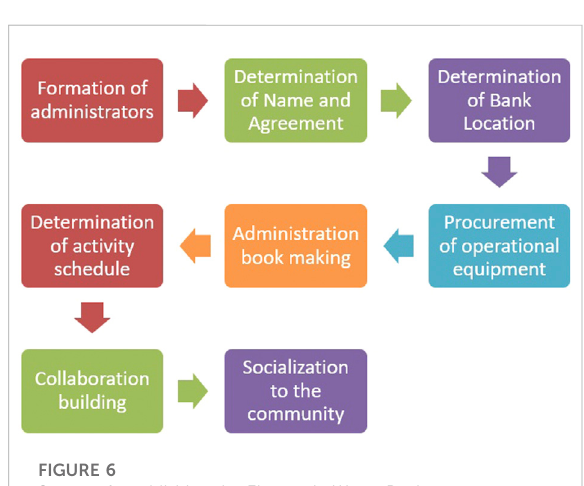
FIGURE 6 Stages of establishing the Electronic Waste Bank